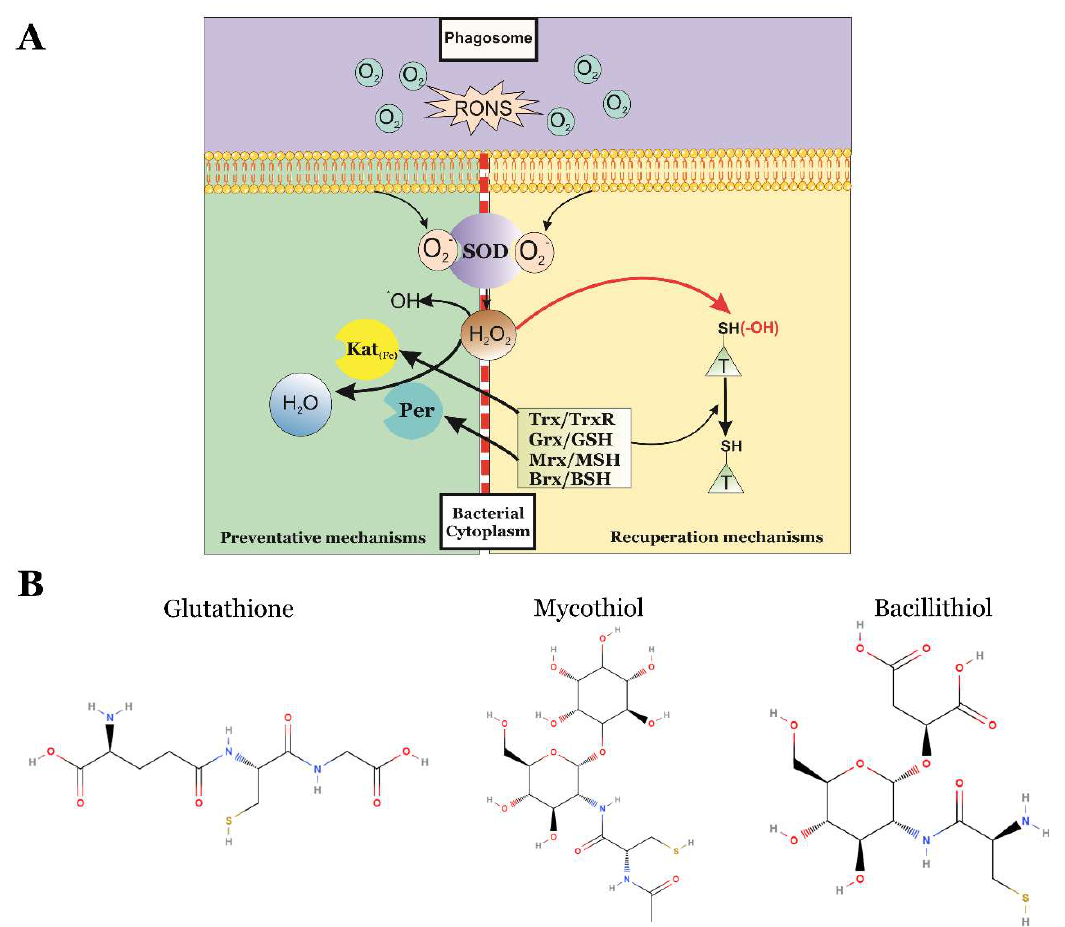
Figure 3. ( A ) After phagocytosis, the RONS biosynthesis produced during the oxidative burst triggers the activation of the redox mechanisms of intracellular bacterial pathogens. Their preventative mechanisms are activated to degrade RONS. If these preventative measures are not su ffi cient, the recuperationmechanismswillrestorethereducedstateofproteinscavengersandotheroxidizedproteins. SOD, superoxide dismutases; Kat, catalases; Per, peroxidases; Trx / TrxR, thioredoxin / thioredoxin reductases; GSH / Grx, glutathione / glutaredoxins; MSH / Mrx, mycothiol / mycoredoxins; BSH / Brx, bacillithiol / bacilliredoxins; T, target proteins. ( B ) Chemical structures of low molecular weight-thiols described in